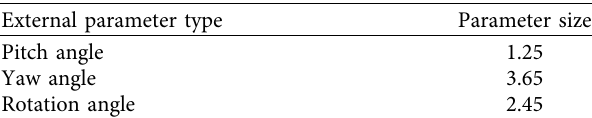
Figure 22: The camera calibration result. Table 2: Calibration results of camera external